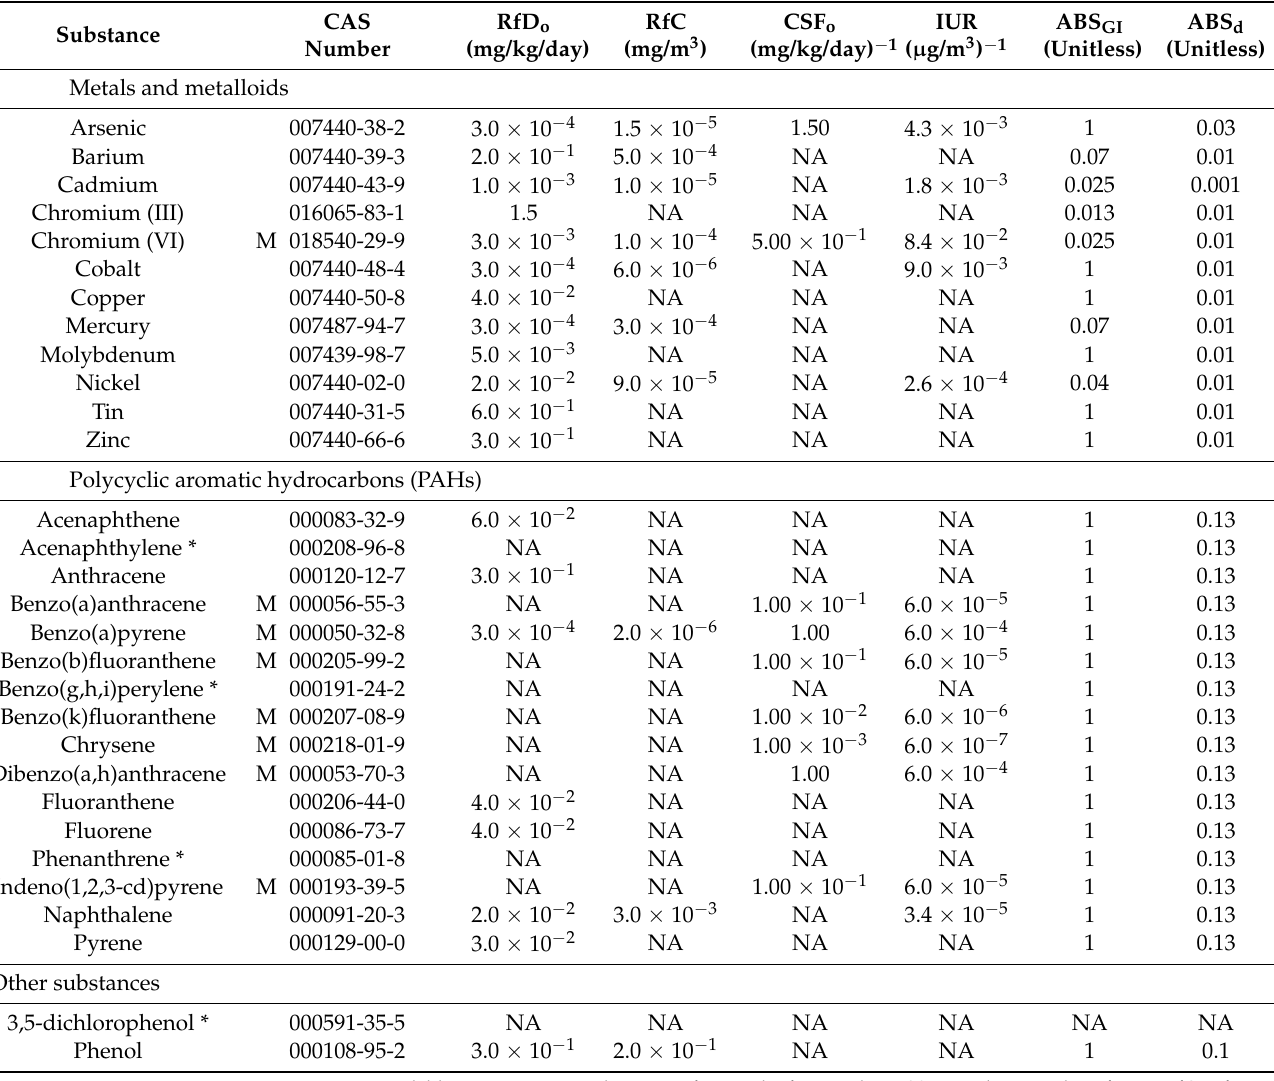
Table 6. Chemical-specific parameter values